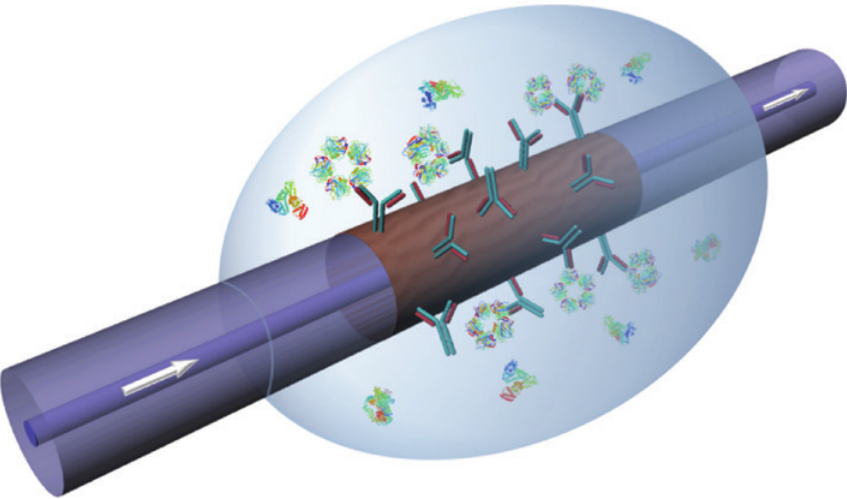
Figure 1: Schematic illustration of the surface sensing of biomolecules by an optical fiber-based device coated with a nanometric scale